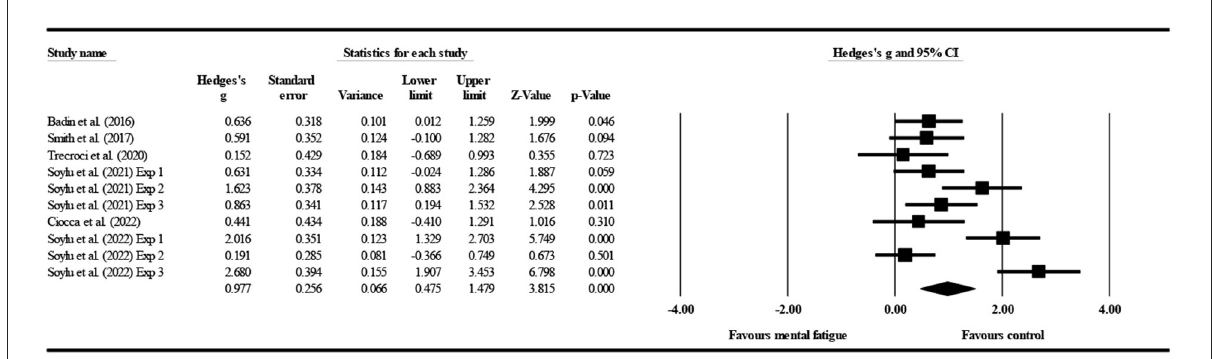
FIGURE6 Forest plot of changes in errors with the comparison of two conditions (mental fatigue and control condition). The results displayed are effect sizes with 95% CIs.